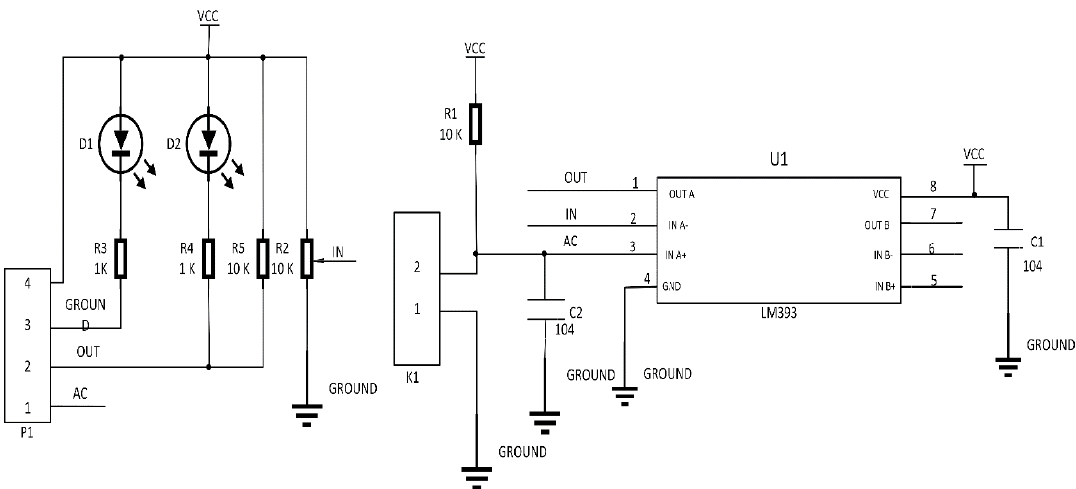
Figure 5. Circuit diagram of the moisture soil sensor operating principle.